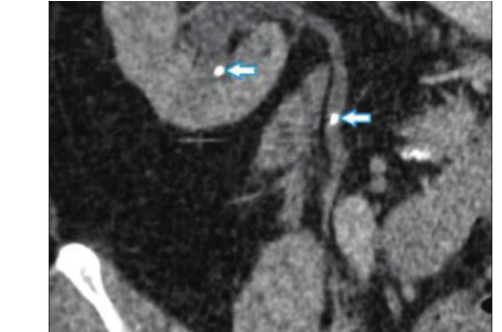
Figure 2 - CT scan of the kidney and ureter. The symptoms of urolithiasis are visualized: heterogeneity of the shape and pattern of the kidney, localization of round stones in the lower renal calyx and middle third of the ureter measuring 4 × 1 mm (both indicated by